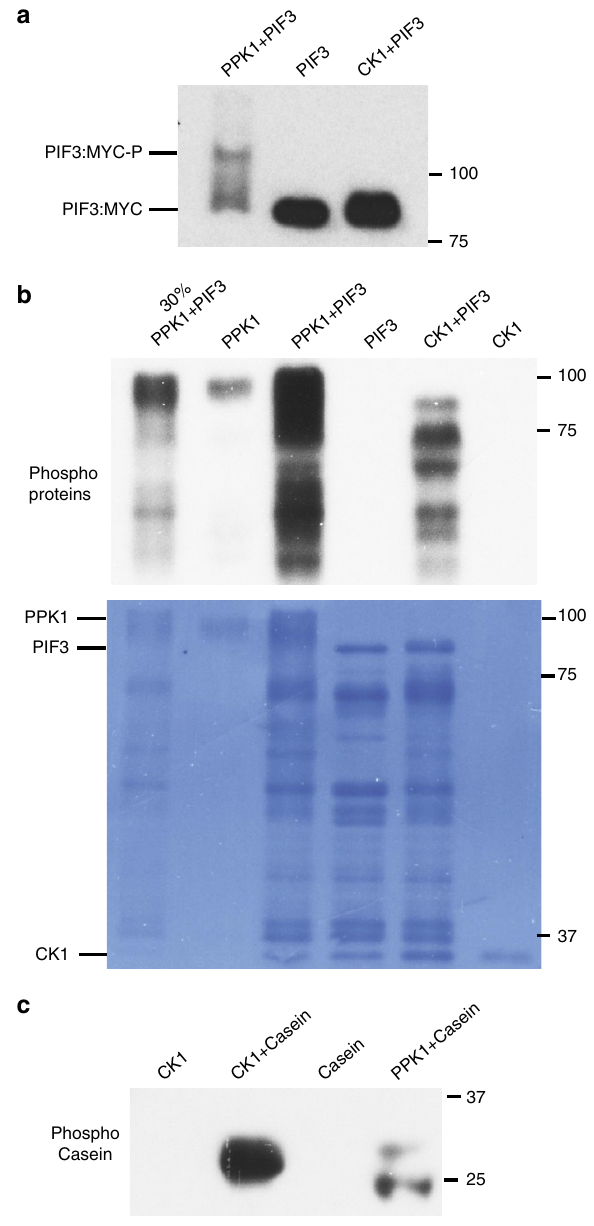
Figure 5 | Specificity of in vitro phosphorylation of PIF3 by PPK1. ( a ) Unlike PPK1, CK1 does not induce a strong phosphorylation-related mobility-shift in PIF3 in vitro . PIF3 from the in vitro kinase assays as indicated was detected by immunoblot using a MYC antibody. CK1: rat Casein Kinase 1d. ( b ) PIF3 phosphorylation by CK1 is qualitatively different and quantitatively less than that by PPK1. Phosphoproteins from the indicated in vitro kinase assays were detected by immunoblot using pIMAGO-biotin. Signals from the kinase-only tracks indicate auto- phosphorylation activity of PPK1. A dilution (30%) of the proteins in the third lane was loaded in the first lane. Bottom panel shows the coomassie- stained membrane. Lower bands are presumptive PIF3 degradation products. ( c ) Casein phosphorylation by CK1 is greater than, and qualitatively different to, that by PPK1. Phospho-Casein from the indicated in vitro kinase assays was detected by immunoblot using